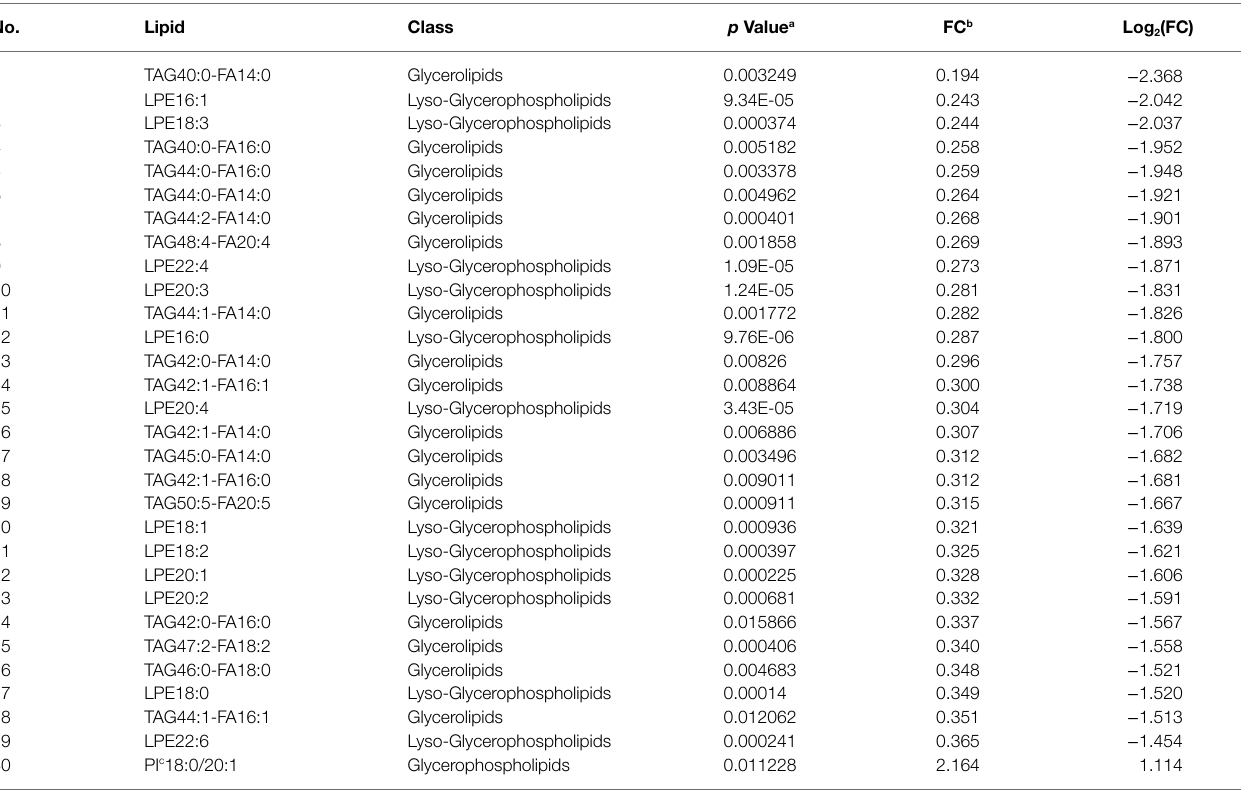
TABLE 8 | Top 30 lipids with different levels between NPC patients with a stage II tumor and NPC patients with a stage III or IV tumor.